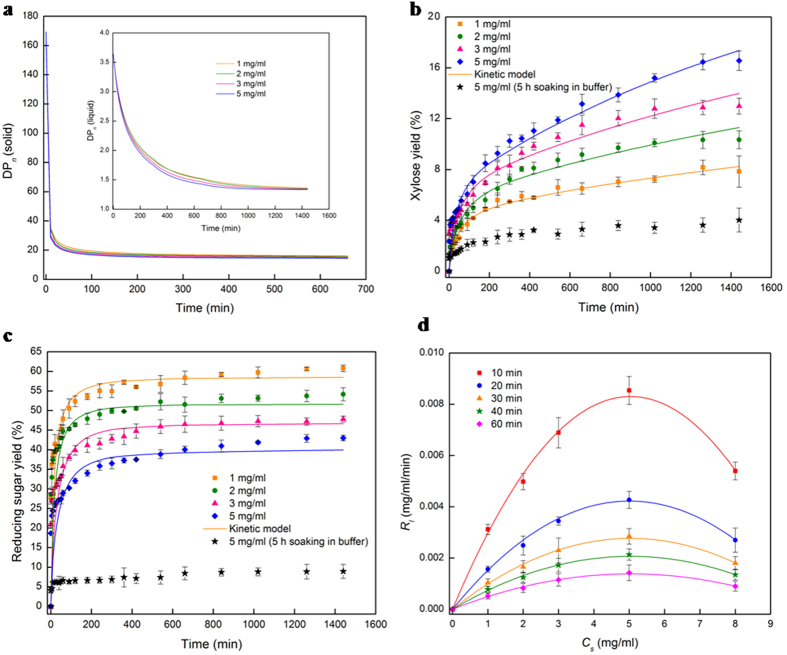
Number average Degree of Polymerization (DPn), sugar yields, and optimal substrate loading.(a) Temporal Dynamics of the number average Degree of Polymerization (DPn) in the solid phase, and inset of (a) is in the liquid phase in enzymatic hydrolysis of xylan. (b) Xylose yield. (c) Reducing sugar yield. (d) Substrate inhibition in the liquid phase. In (b) and (c) the yields of xylose and reducing sugar are obtained from the expression: Y = C/Cs, where Y and C represent the yield and the concentration of the products in the liquid phase, respectively. In (d) the reaction rate in the liquid phase decreases with substrate loading above 5 mg/ml, and Cs = 5 mg/ml is obtained as the ‘optimal substrate loading’. Solid points are the experimental data, and solid lines are the model simulations (a,b,c) and the best-fit quadratic curves (d).